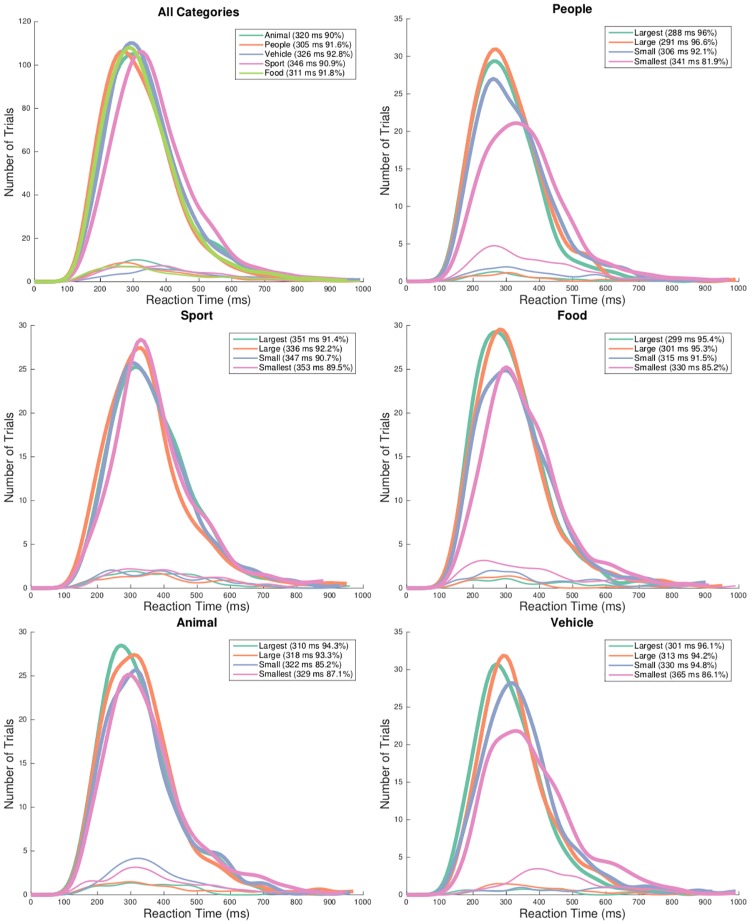
RT distributions for target objects at different levels of scales.[The top-left sub-figure] RT distributions for correct (thick line) and incorrect (thin line) responses for each target category with the percentage of responses pooled across all subjects and time characterized with 10 ms time bins (regardless of scales). Access to processing the people category was faster than the others (s.). [The other sub-figures] RT distributions with five categories as targets respectively. The time-course and accuracy of processing sport category were both similar across scales (t-test both n.s.), while the performance was variant with the change in scales with other four categories as targets (t-test both s. for other four categories). Note that (n.) s. refers to (no) significance in the t-tests.